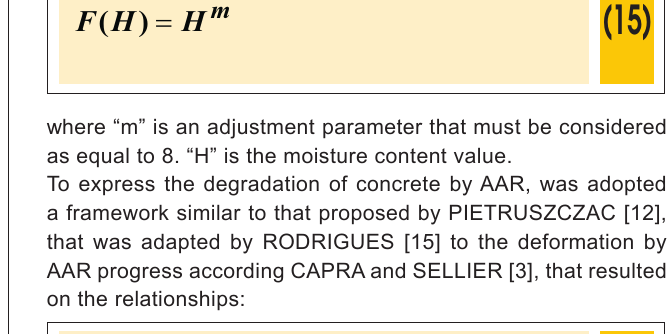
Figure 4 – Schematic chart for definition of the parameters “ e ” and “A ” o